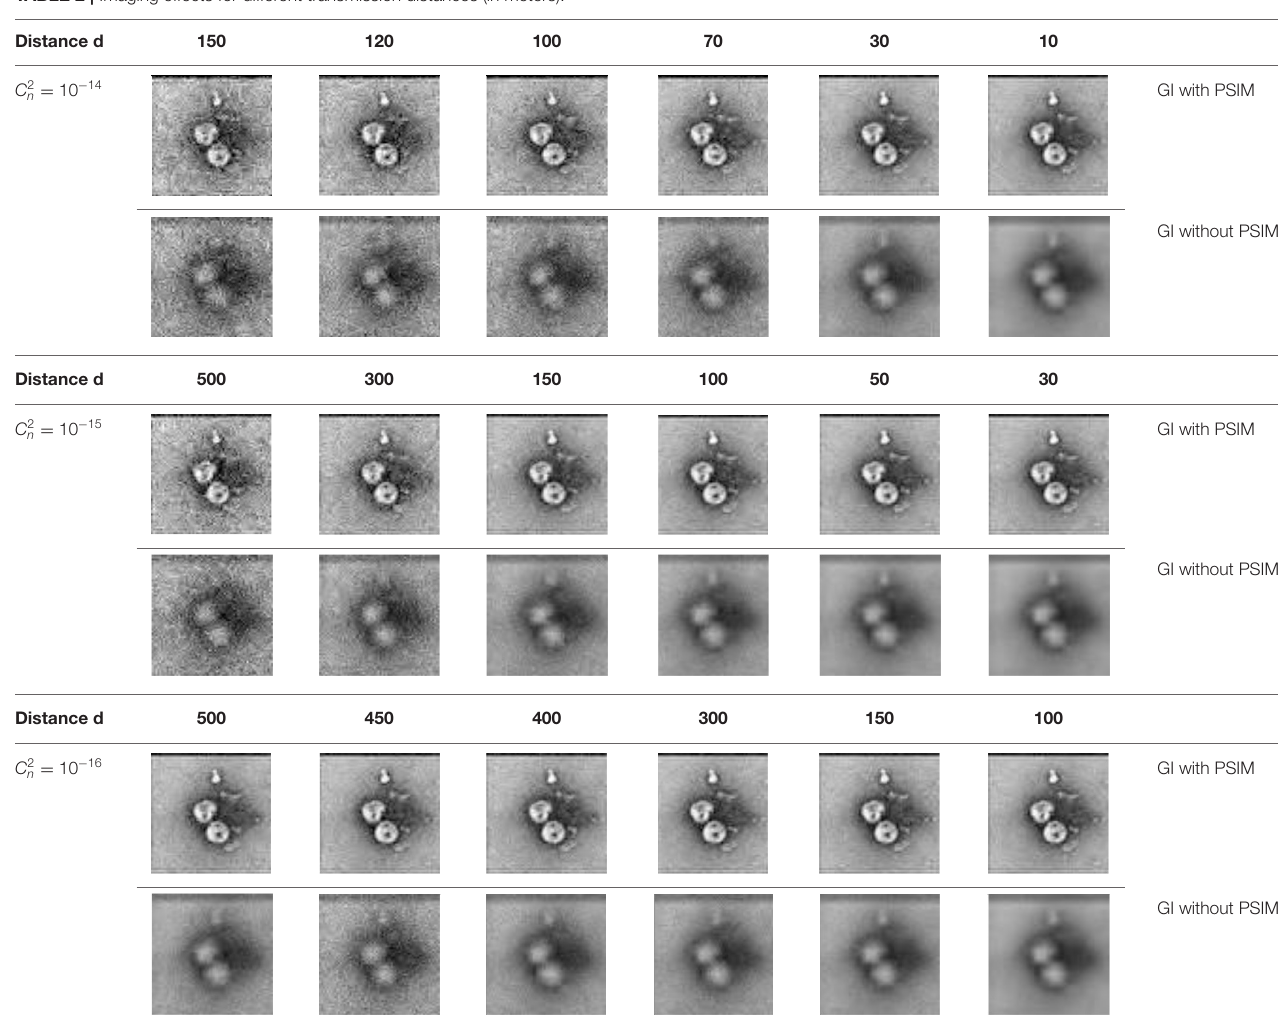
TABLE 2 | Imaging effects for different transmission distances (in